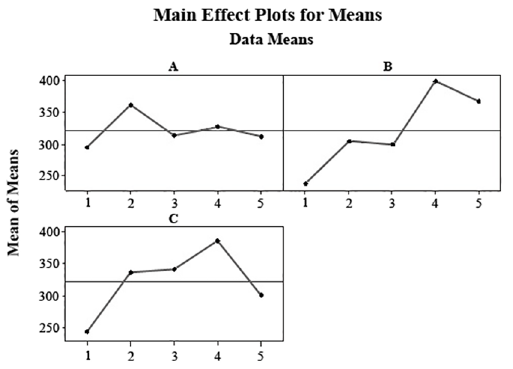
Figure 6. Main effect plots for flexural strength for a (heating rate),